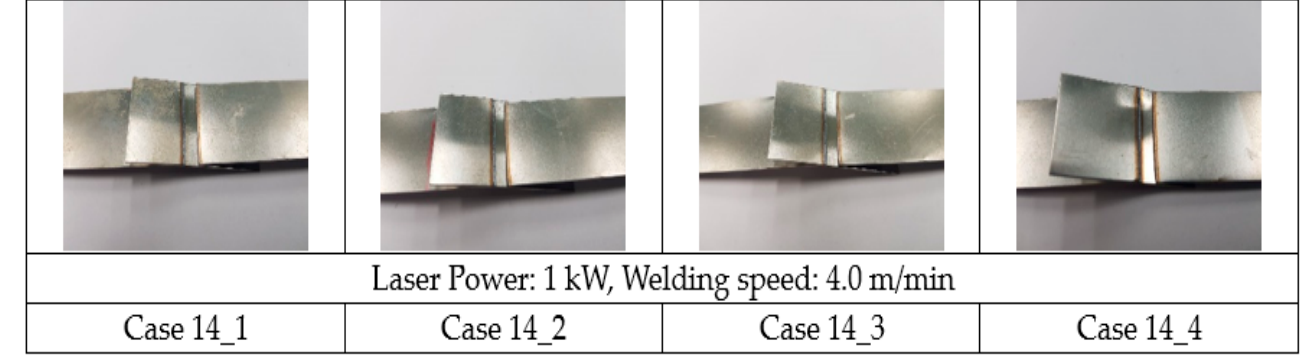
Figure 16. Case 14 condition appearance shape after shear fracture.